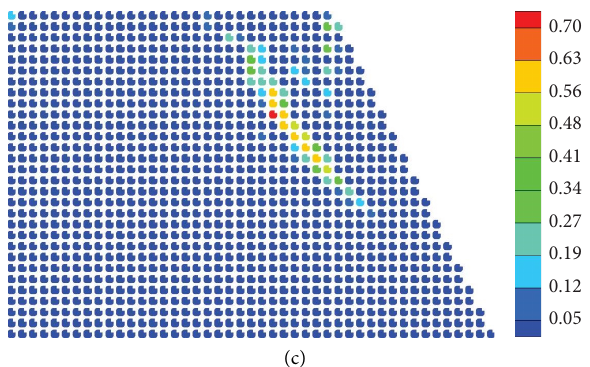
Figure 12: Variations of the residual cohesion parameter with the progressive failure process of the slope: (a) step � 200; (b) step � 250; (c) step �